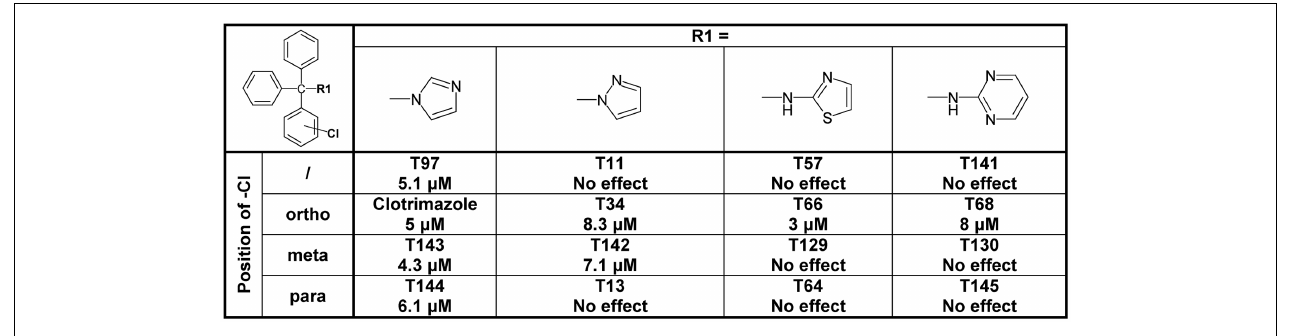
were determined by application of two or three concentrations of each triarylmethane to multiple cells ( n ranging from 3 to 8 per concentration).The SD values are not shown for clarity; SD values typically ranged between 5 and 15%.